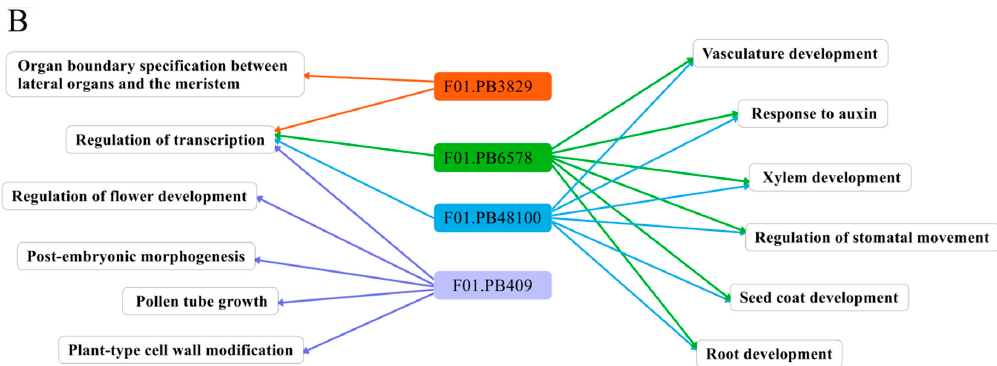
Figure 9. Gene ontology classification of seed-specific TFs. ( A ) The results were summarized in three main categories: cellular component, molecular function, and biological process. ( B ) The biological process of four TFs related to seed formation and development. F01.PB3829, F01.PB48100, F01.PB6578, and F01.PB409 represented CoMYB1, CoMYB2, CoMYB3, and CoMADS2, respectively.